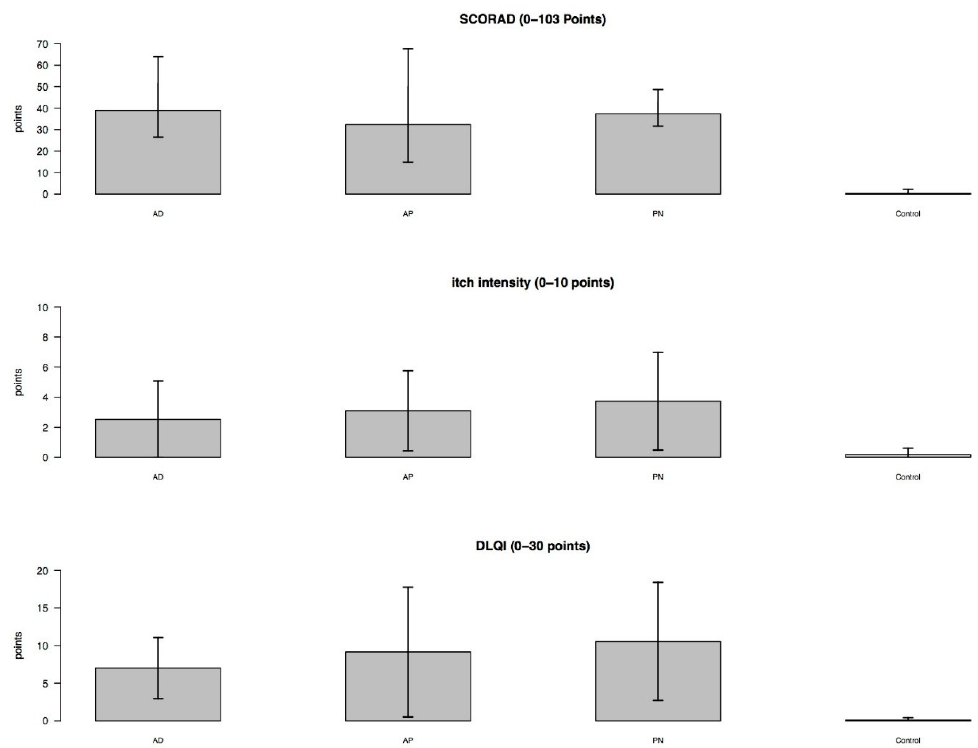
Biology 2021 , 10 , 1008 7 of 19 Figure 1. Clinical parameters (bar plots with standard deviation). SCORAD: severity scoring of atopic dermatitis; DLQI: dermatology life quality index; AD: classic atopic dermatitis; AP: atopic prurigo; PN: non-atopic prurigo nodularis.